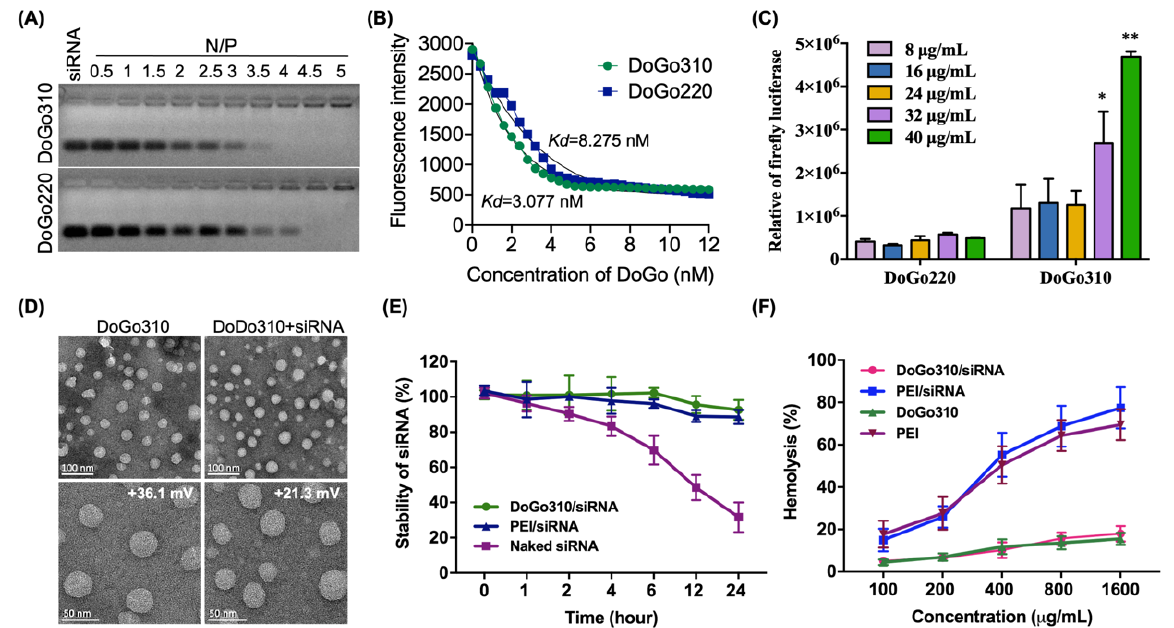
Figure 1. Physicochemical properties of DoGo310. ( A ) Assessment of siRNA-binding affinity by gel electrophoresis assay; ( B ) apparent dissociation constant ( K d ) of DoGo220 and DoGo310 lipids with siRNA measured by fluorescence quenching assay; ( C ) comparison of plasmid-delivery efficiency of DoGo220 and DoGo310 lipids. All data are presented as mean ± SD from triplicate experiments; * p < 0.05, ** p < 0.001 compared to untreated cells; ( D ) Morphology of DoGo310 lipid after formulation. TEM image shows size of the DoGo310 LNP after siRNA loading; ( E ) siRNA protection efficiency of DoGo310 LNP. Naked siRNA and siRNA loaded to PEI are shown as control; ( F ) hemolysis assay of DoGo310 LNP alone or loaded with siRNA.